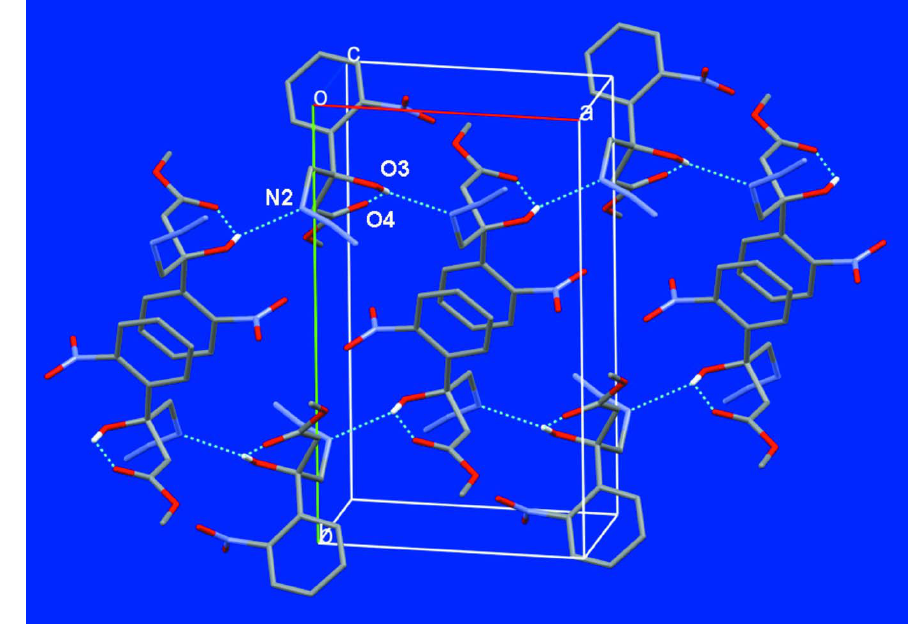
Figure 2 A view along the a axis of the crystal packing of the title compound, showing the intra and intermolecular hydrogen bonds as dashed lines (see Table 1 for